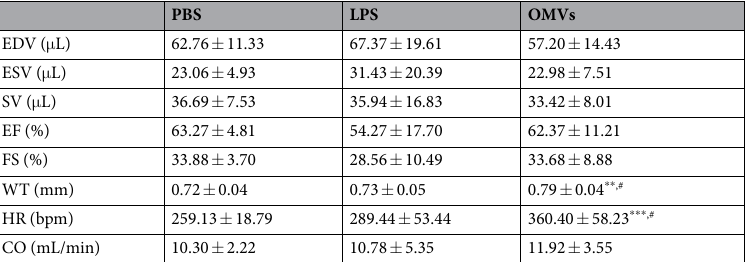
Table 1. Cardiac data acquired 12 h after i.p. injection of PBS alone, LPS (40 μ g) or OMVs (15 μ g) in C57BL/6 mice (10 mice per group). Abbreviations: EDV, end diastolic volume; ESV, end systolic volume; SV, stroke volume; EF, ejection fraction; FS, fraction shortening; WT, wall thickness; HR, heart rate; CO, cardiac